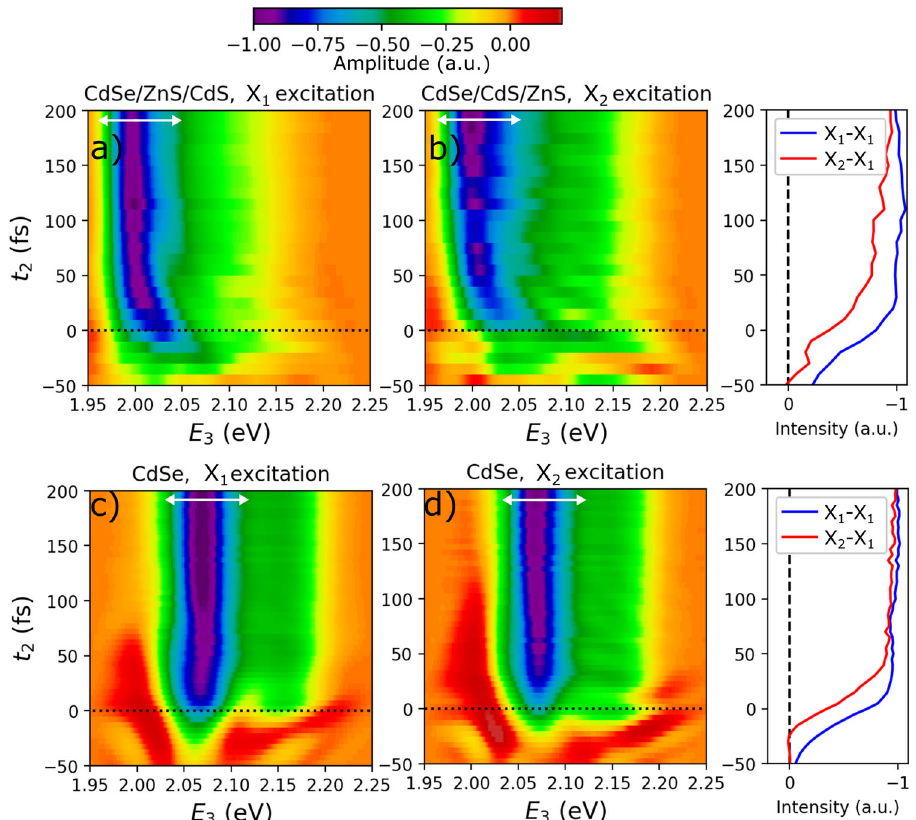
Fig. 3 Two-dimensional electronic spectroscopy (2DES) projections reveal exciton dynamics. Projecting the 2DES spectra along the E 3 axis to produce pseudotransient absorption (pseudo-TA) spectra. a , b Pseudo-TA spectra of CdSe/CdS/ZnS QD for X 1 and X 2 excitation, respectively. The side panel shows projections of the X 1 – X 1 (blue) and X 2 – X 1 (red) peaks for CdSe/CdS/ZnS. c , d Pseudo-TA spectra of CdSe QD for X 1 and X 2 excitation, respectively. The side panel shows projections of the X 1 – X 1 (blue) and X 2 – X 1 (red) peaks for CdSe. White arrows in ( a – d ) show the integration area for generating the transients. The color bar corresponds to the normalized amplitude of the 2DES signal in ( a – d